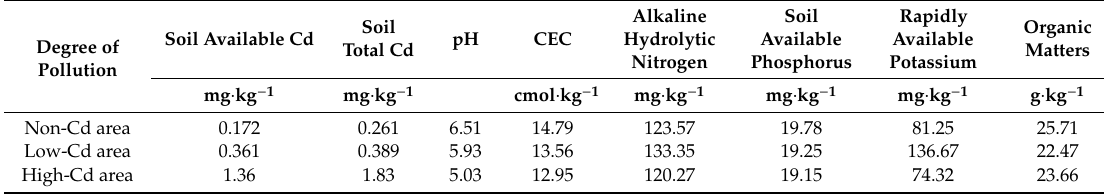
Table 1. Selected soil physicochemical